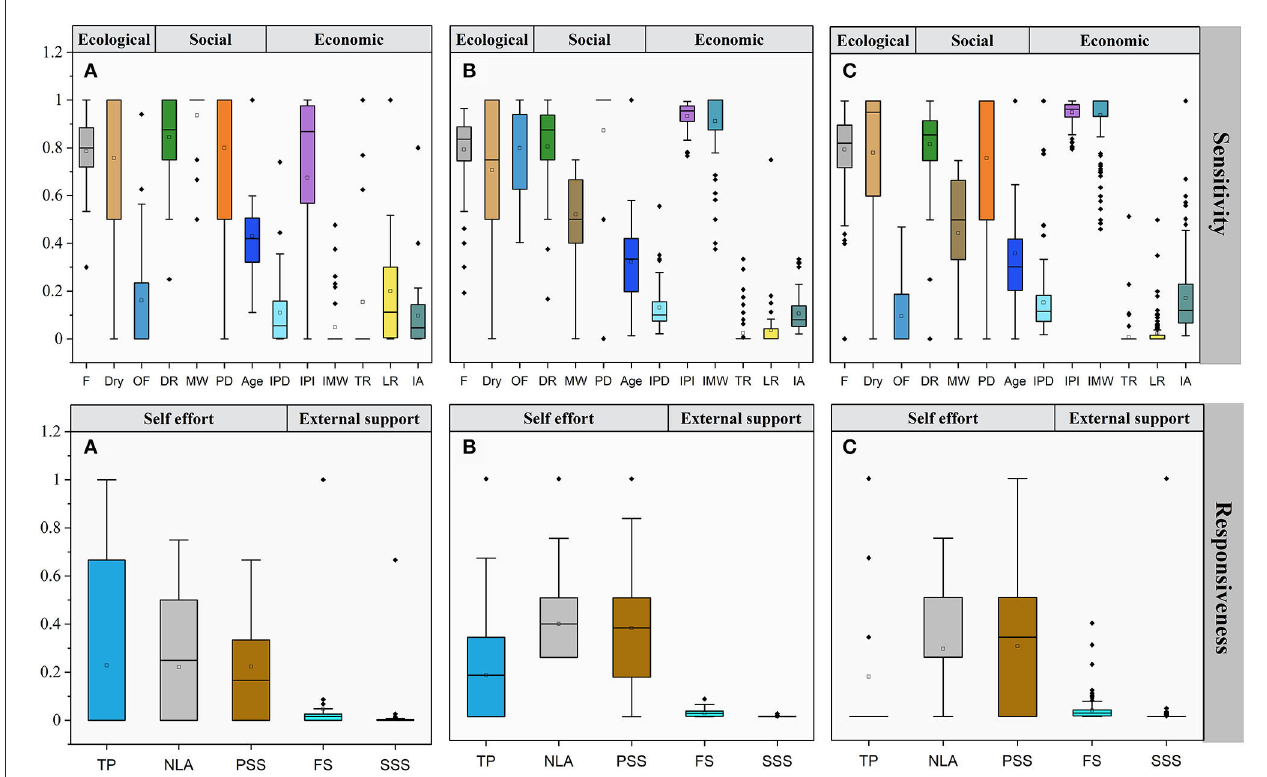
FIGURE7 Characteristics of farmer livelihood vulnerability with different livelihood types are different: (A–C) IC, IEDS, and ED types, respectively. The abbreviations all correspond to the interpretation of the indicators in the indicator system in Table 1.